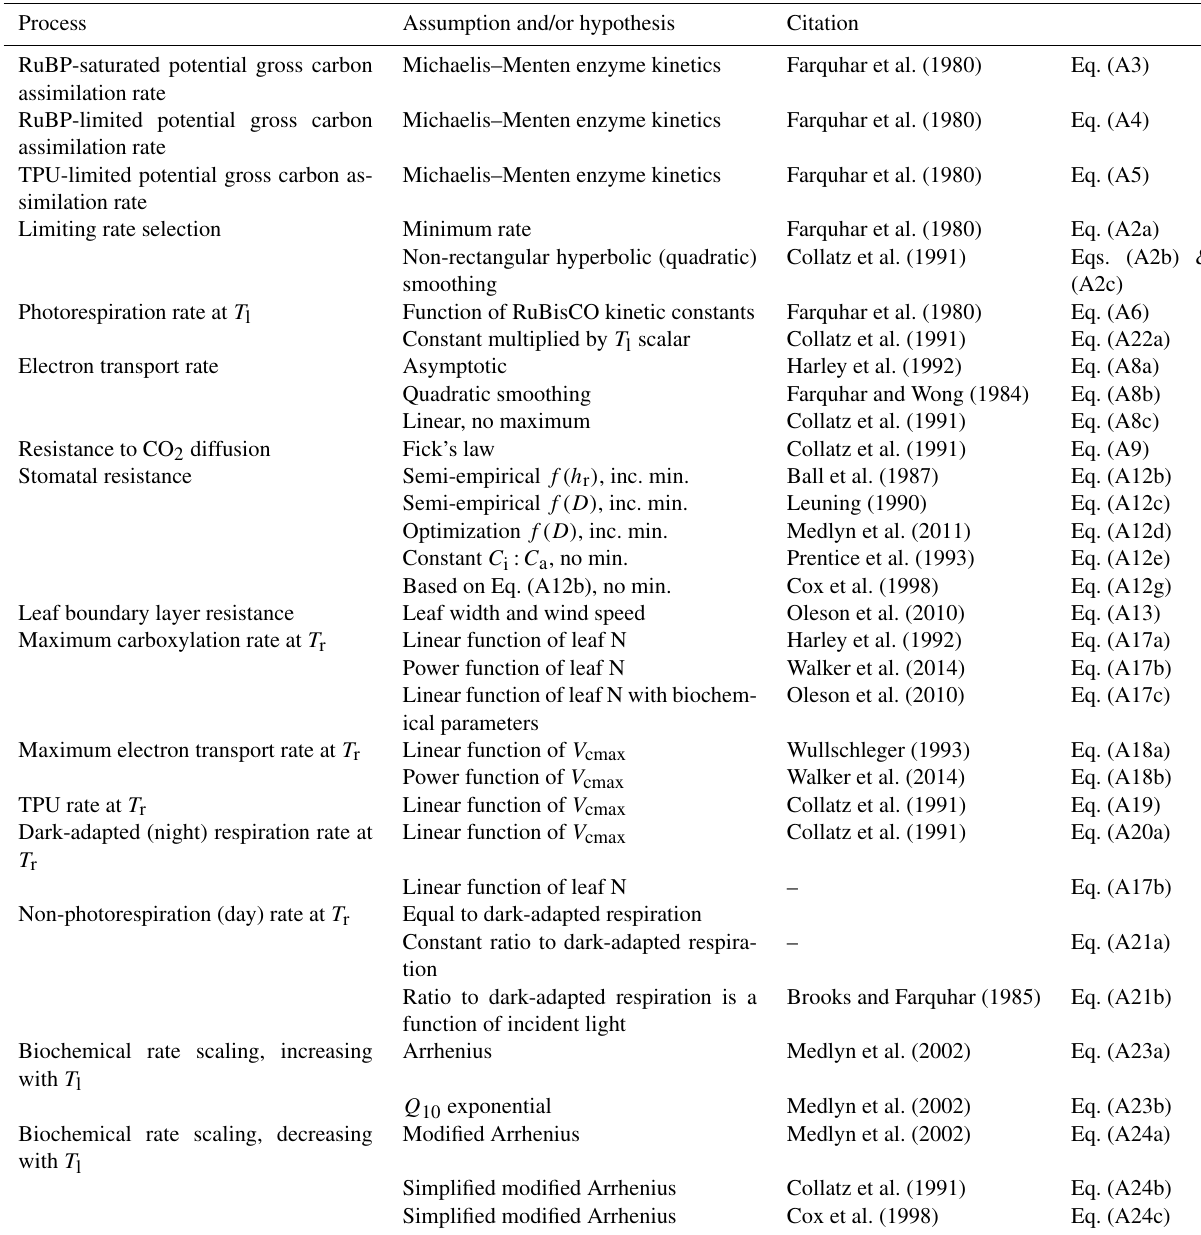
Table 4. Table of processes and